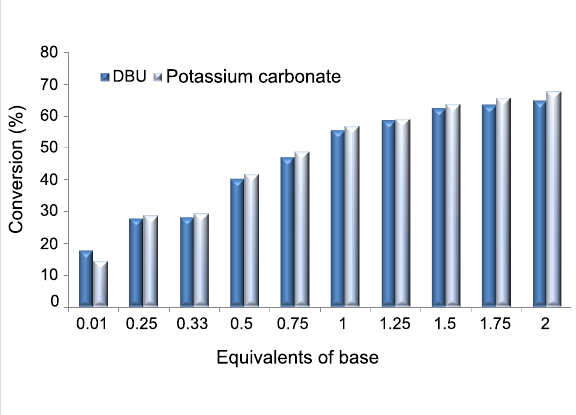
Figure 10: Comparison of base effect on the synthesis of 2-chloro-1- (4-methoxyphenoxy)-4-nitrobenzene ( 7 ) (residence time = 30 s; reactor temperature = 195